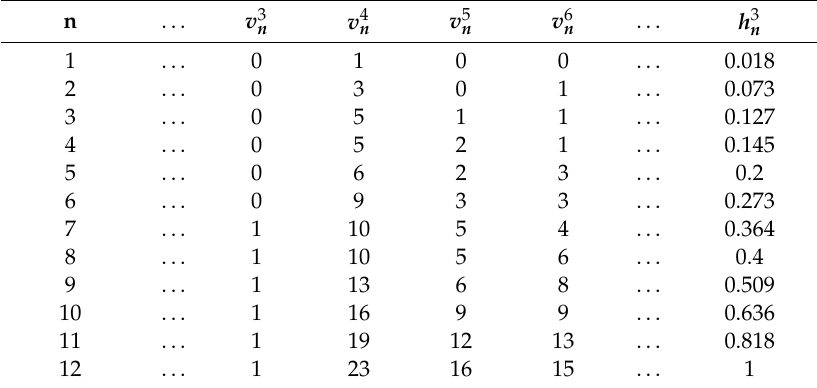
Table 3. Exception information matrix and failure mode probability.